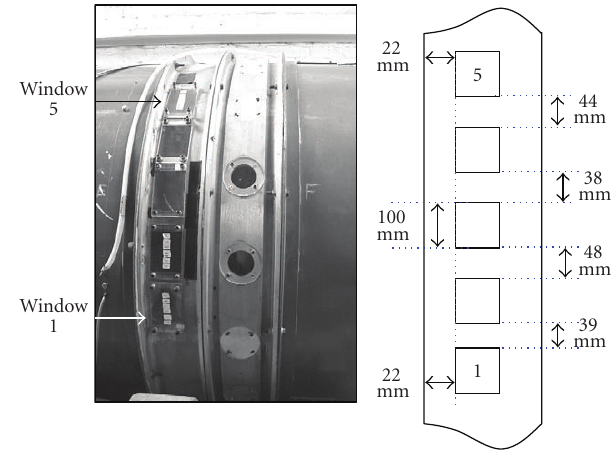
Table 8: The second blade mode peak-to-peak amplitudes (mm) recovered by BTT methods.